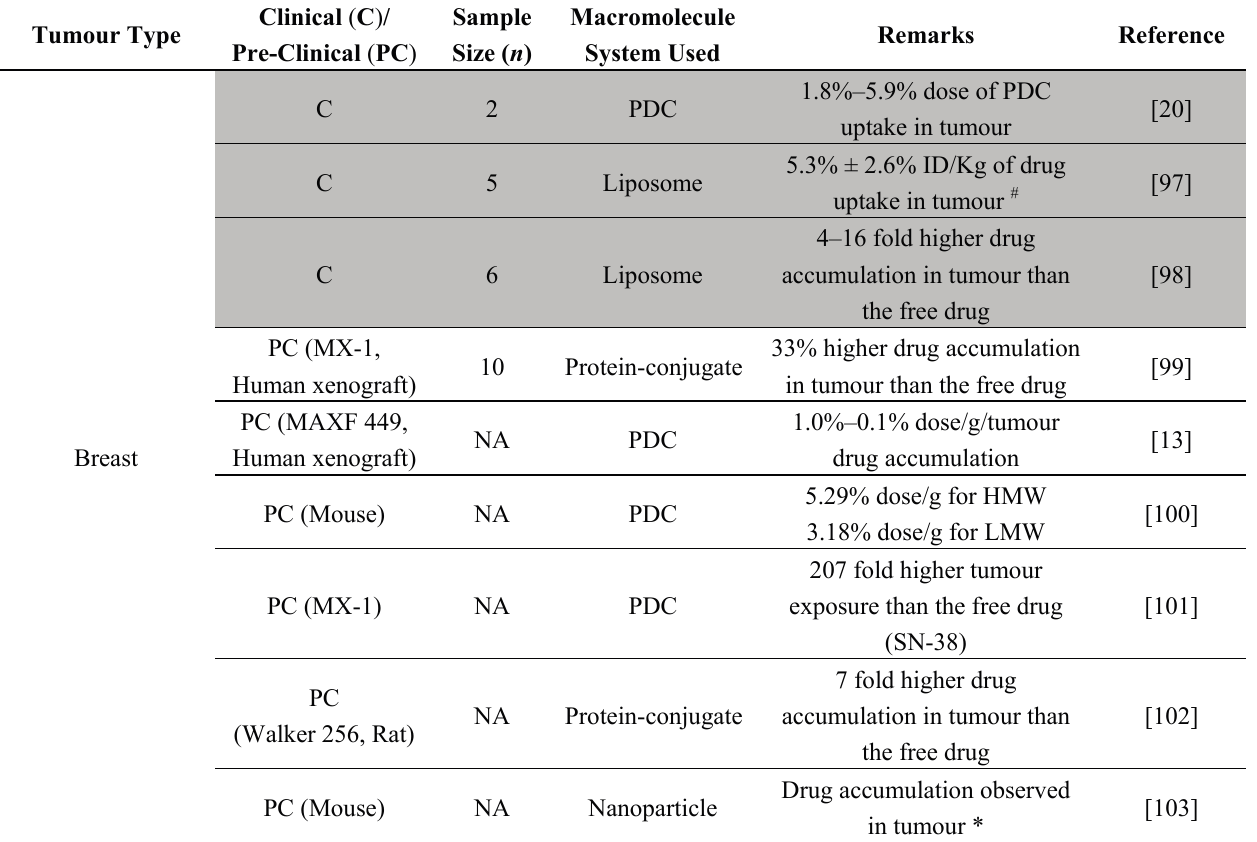
Table 7. Extent of passive accumulation of macromolecular system in different tumour types in both clinical and pre-clinical samples, clinical studies highlighted in